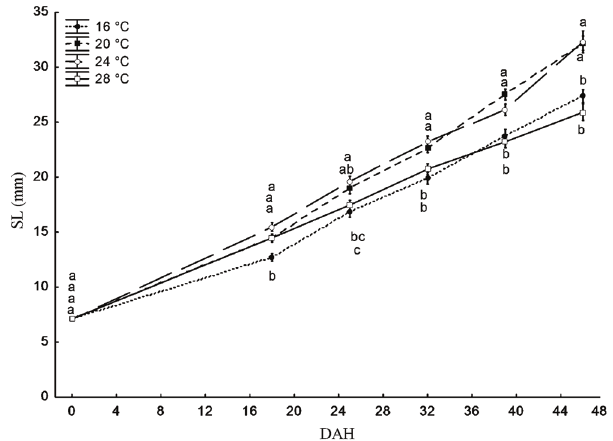
Fig. 1. Standard length (SL) (mean ± standard error) of Aus- trolebias wolterstorffi kept in the laboratory for 46 days after hatching (DAH) under different temperatures. Different letters represent significant mean differences between treatments (ANOVA, Tukey, p <